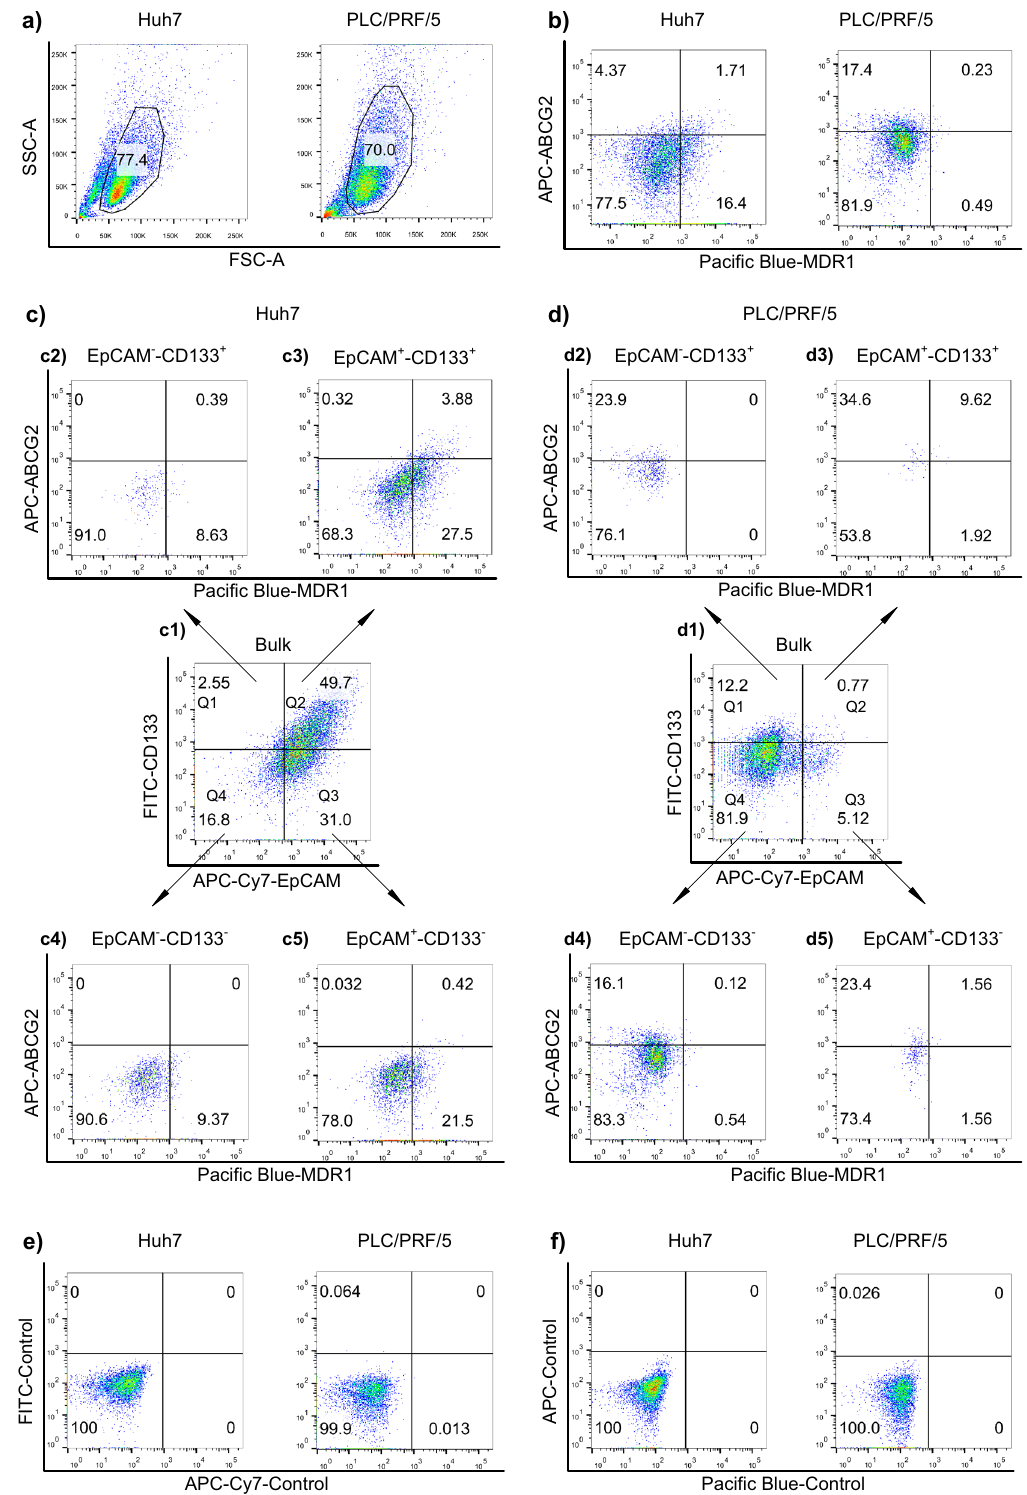
Figure 1. Expression of MDR1 and ABCG2 in the liver cancer stem cell (LCSC) population of Huh7 and PLC/ PRF/5 cells. ( a ) The gating of viable cells using forward scatter (FSC) and side scatter (SSC). ( b ) The percentage of MDR1 + and ABCG2 + expression in the bulk tumor population. ( c1,d1 ) The percentage of LCSC markers EpCAM and CD133 in the bulk tumor population. The cells shown in ( c1 ) and ( d1 ) were divided into four quadrants (Q1, Q2, Q3 and Q4). ( c2–c5,d2–d5 ) The expression of MDR1 and ABCG2 in the cells from Q1, Q2, Q3 and Q4 of ( c1 ) and ( d1 ) was determined. The Huh7 and PLC/PRF/5 cells were stained with IgG isotype- matched control antibodies of ( e ) EpCAM and CD133 and ( f ) MDR1 and ABCG2. Horizontal and vertical axes denote expression intensity. One representative experiment of three is